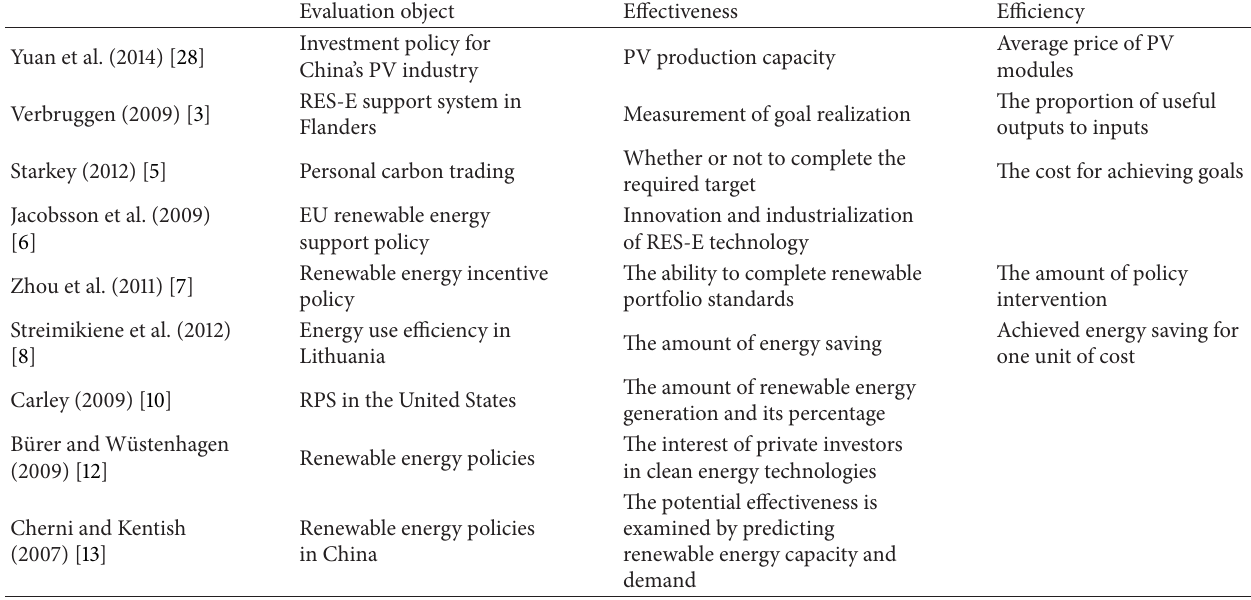
Table 2: Evaluation indexes in related